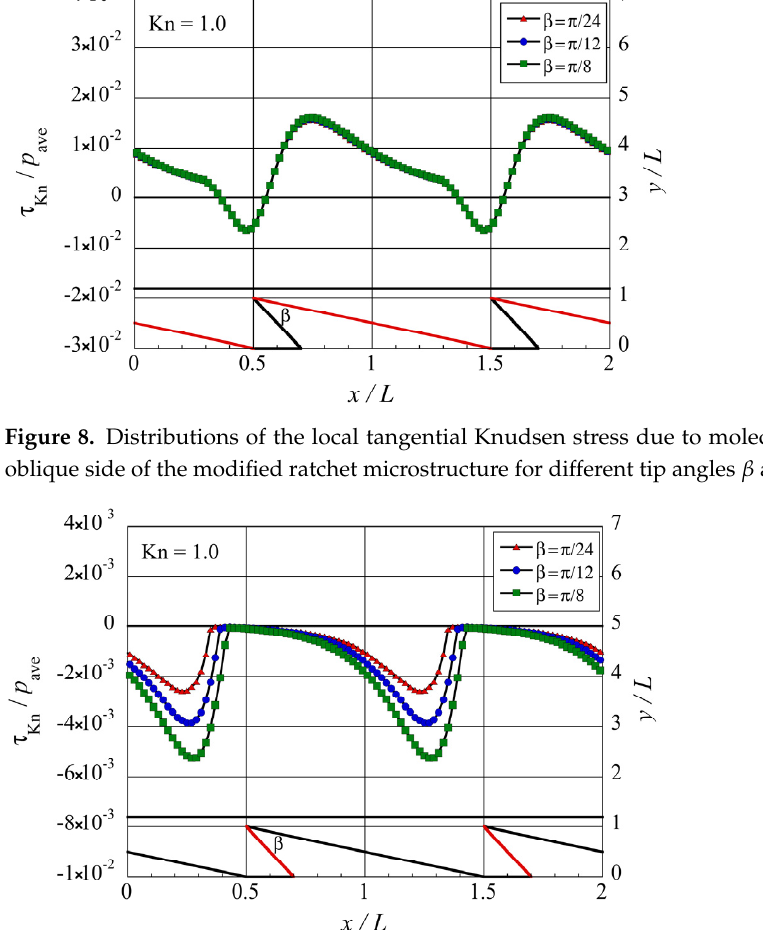
Figure 9. Distributions of the local tangential Knudsen stress due to molecules coming from the modified side of the modified ratchet microstructure, for different tip angles 𝛽 at Kn = 1 .